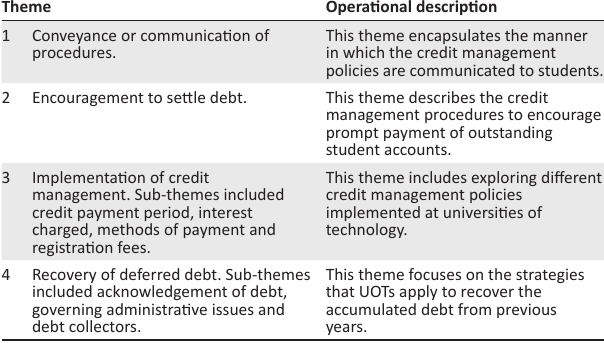
TABLE 1: Themes and operational